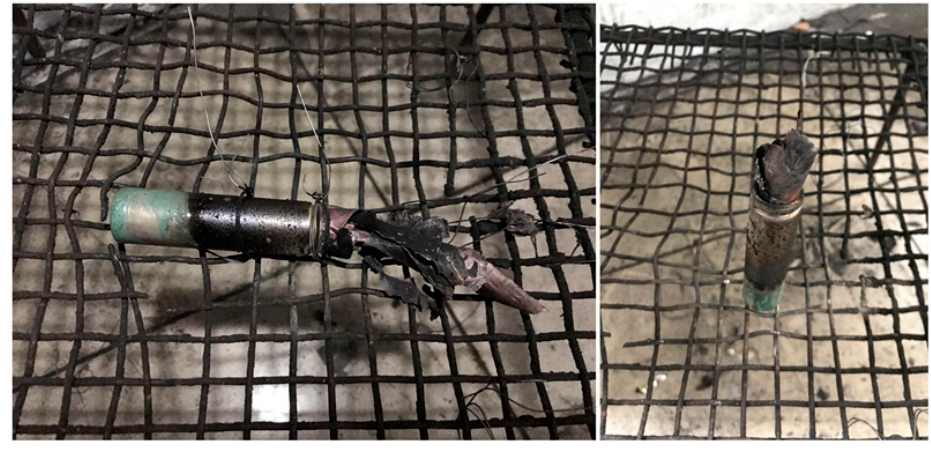
Figure 4. The photographs of the overcharged battery after thermal runaway test.